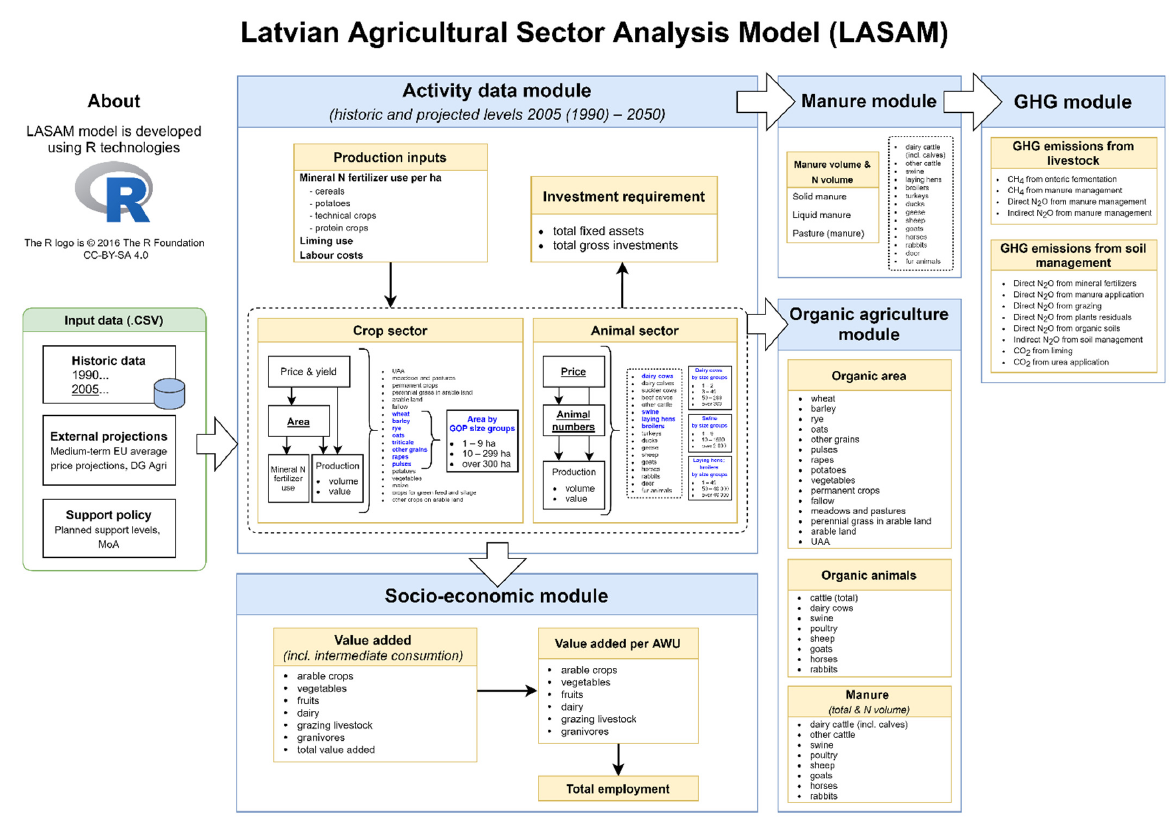
Figure 1. General overview of the LASAM model structure.